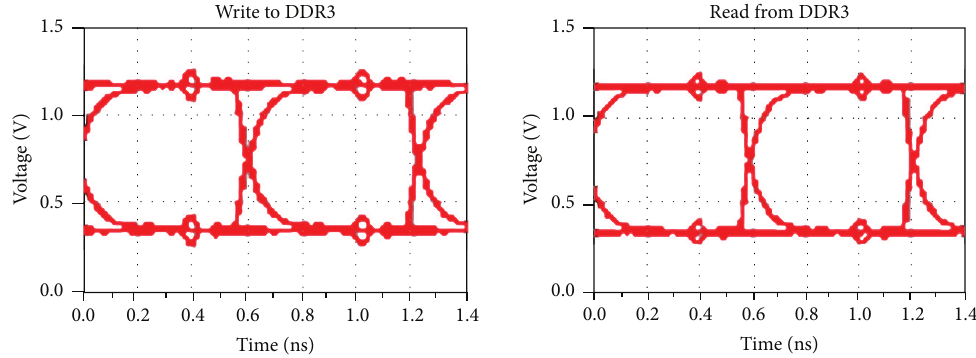
Figure 10: Simulation eye diagram for the proposed